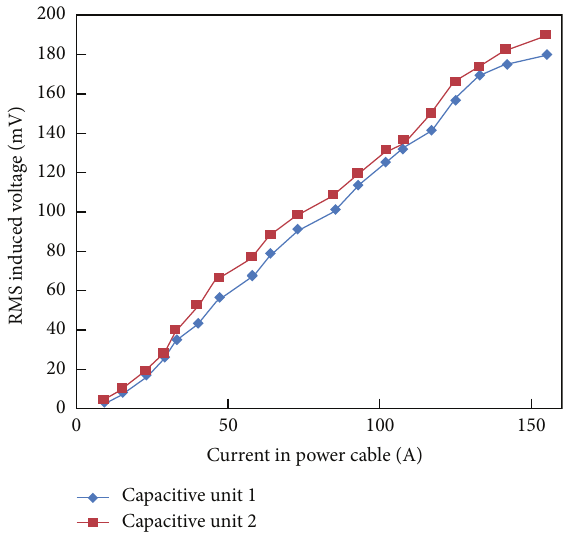
Figure 17: Induced load voltage in capacitive energy harvesters as a function of cable current.